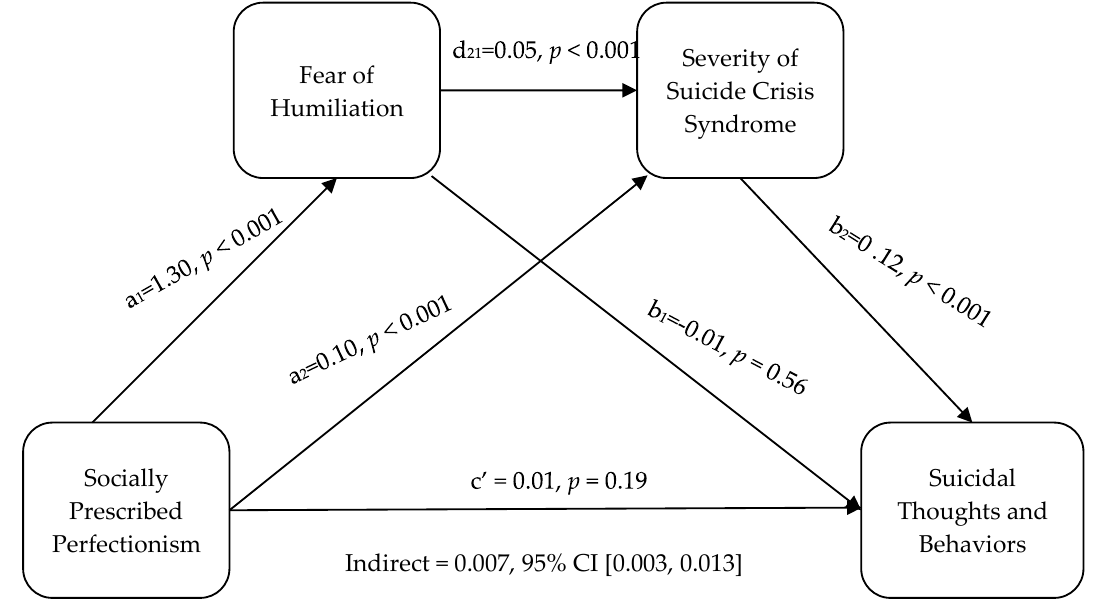
Figure 3. The relationship among the variables in the serial multiple mediation analysis.